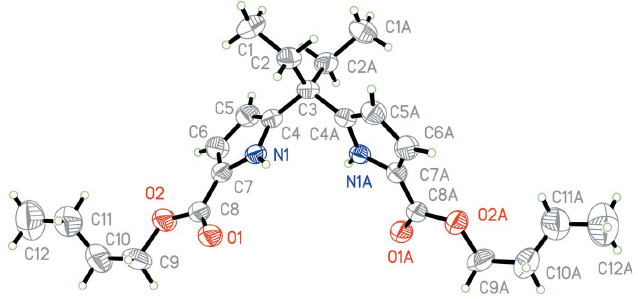
Figure 1 ORTEP diagram for the title compound, with displacement ellipsoids drawn at the 30% probability level. [Symmetry code: (A) x , 1